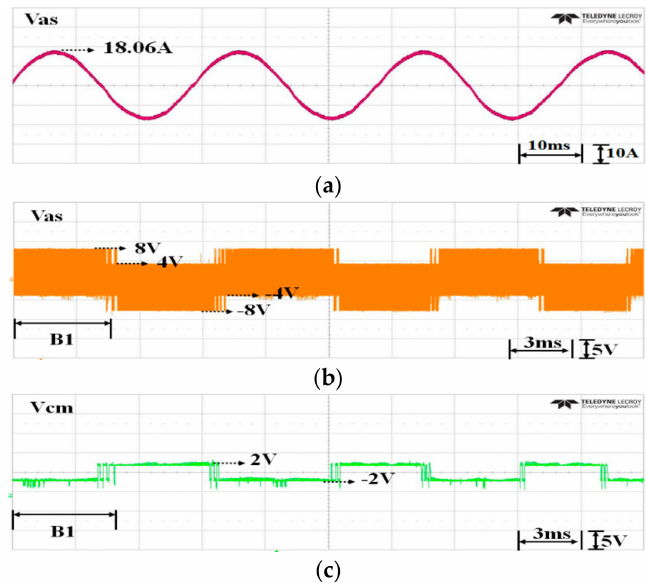
Figure 10. Experimental waveforms corresponding to the RSPWM3: ( a ) phase current; ( b ) phase voltage; ( c ) CMV.